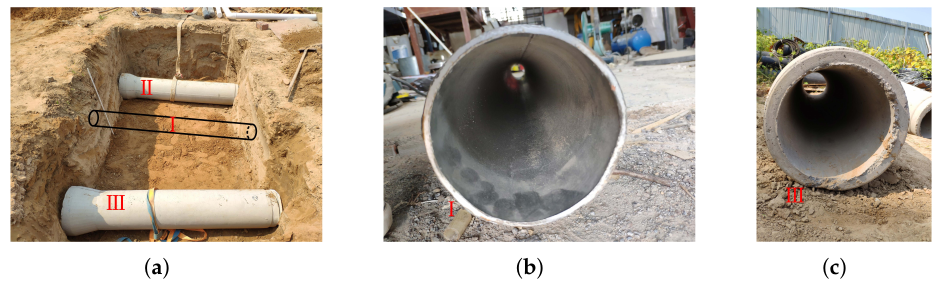
Figure 12. Diagram of experimental physical model distribution. ( a ) Physical model deployment of experimental data: ( b ) I, ( c )